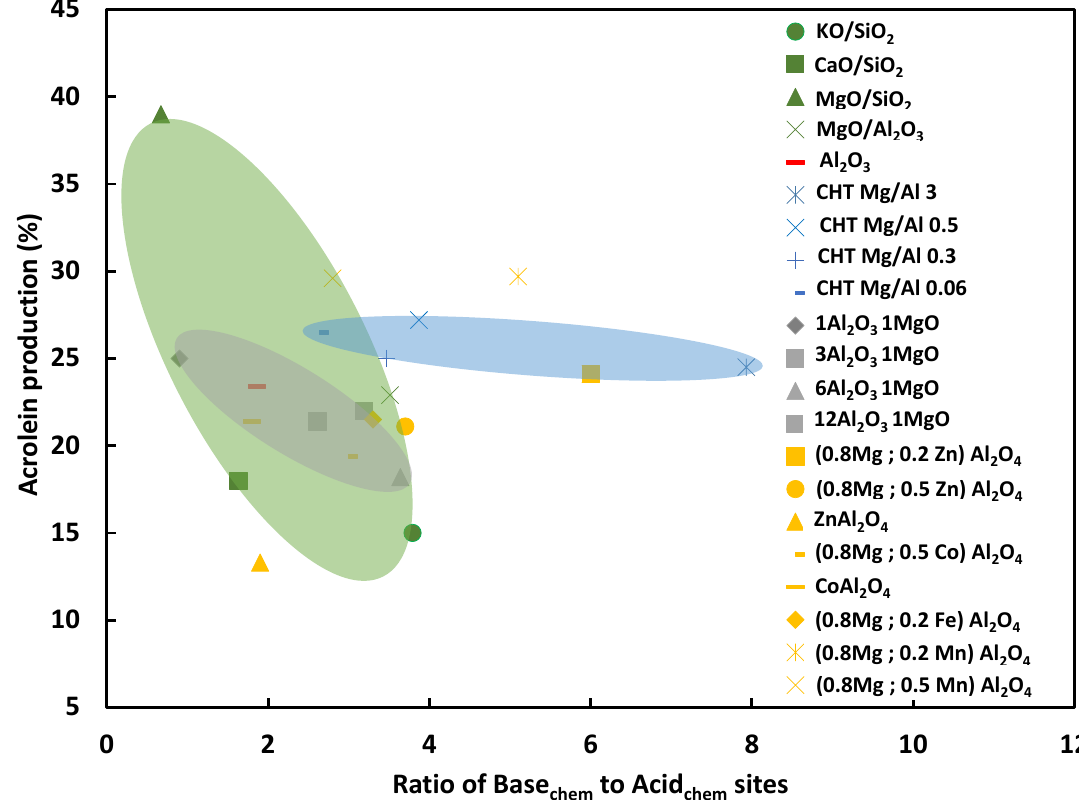
Figure 4. Ratio of strong basic to strong acidic sites obtained for fresh catalysts versus acrolein production determined by Lilic et al. and Folliard et al. [38–42].